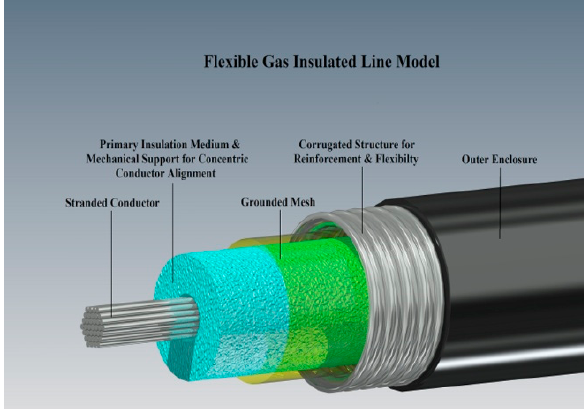
Figure 1. Schematic of modular and flexible gas insulated line.